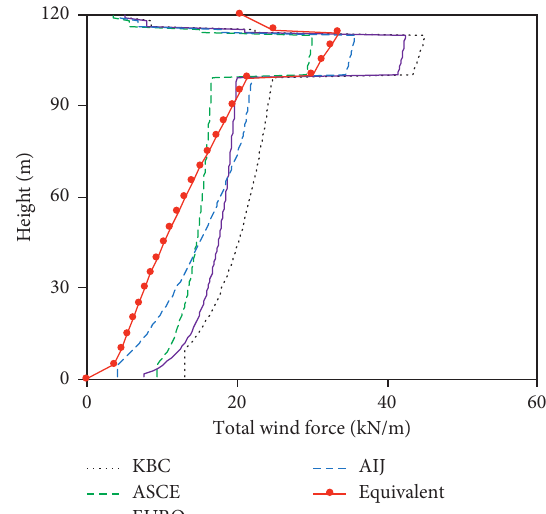
Figure 15: Along-wind forces evaluated using design codes and aeroelastic test-based equivalent